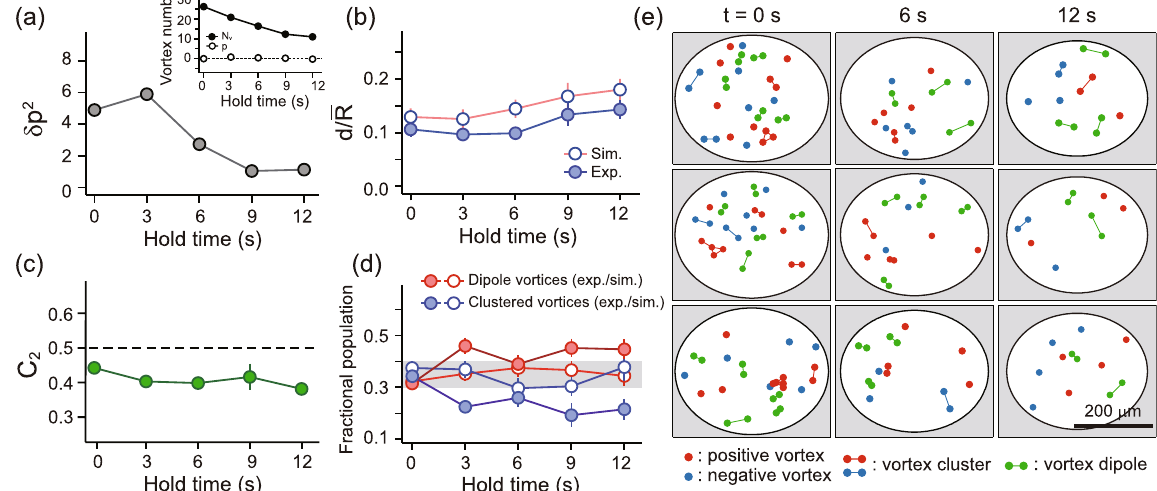
Figure 5. Characterization of decaying 2D quantum turbulence. Various properties of the turbulent BEC were measured based on its vortex configuration as a function of the hold time: ( a ) vortex polarization variance, δ p 2 , where the inset shows N v = N + + N − and p = N + − N − , and N ± is the number of positive (negative) vortices; ( b ) mean vortex dipole moment d divided by the condensate radius = R R R ; ( c ) second-order vortex sign x y correlation function C 210 ; and ( d ) fractional populations of dipole vortices and clustered vortices 18, 19 . Examples of the vortex configuration data including the vortex classification results are displayed in ( e ) for various hold times t . Each data point in ( a – d ) was obtained from fifteen to twenty measurements of the same experiment, and each point’s error bar indicates the standard error of the mean of the measurements. The open circles in ( b ) and ( d ) show the simulation results calculated using twenty vortex configurations randomly sampled for the same N ± . The gray region in ( d ) indicates the range of the simulation